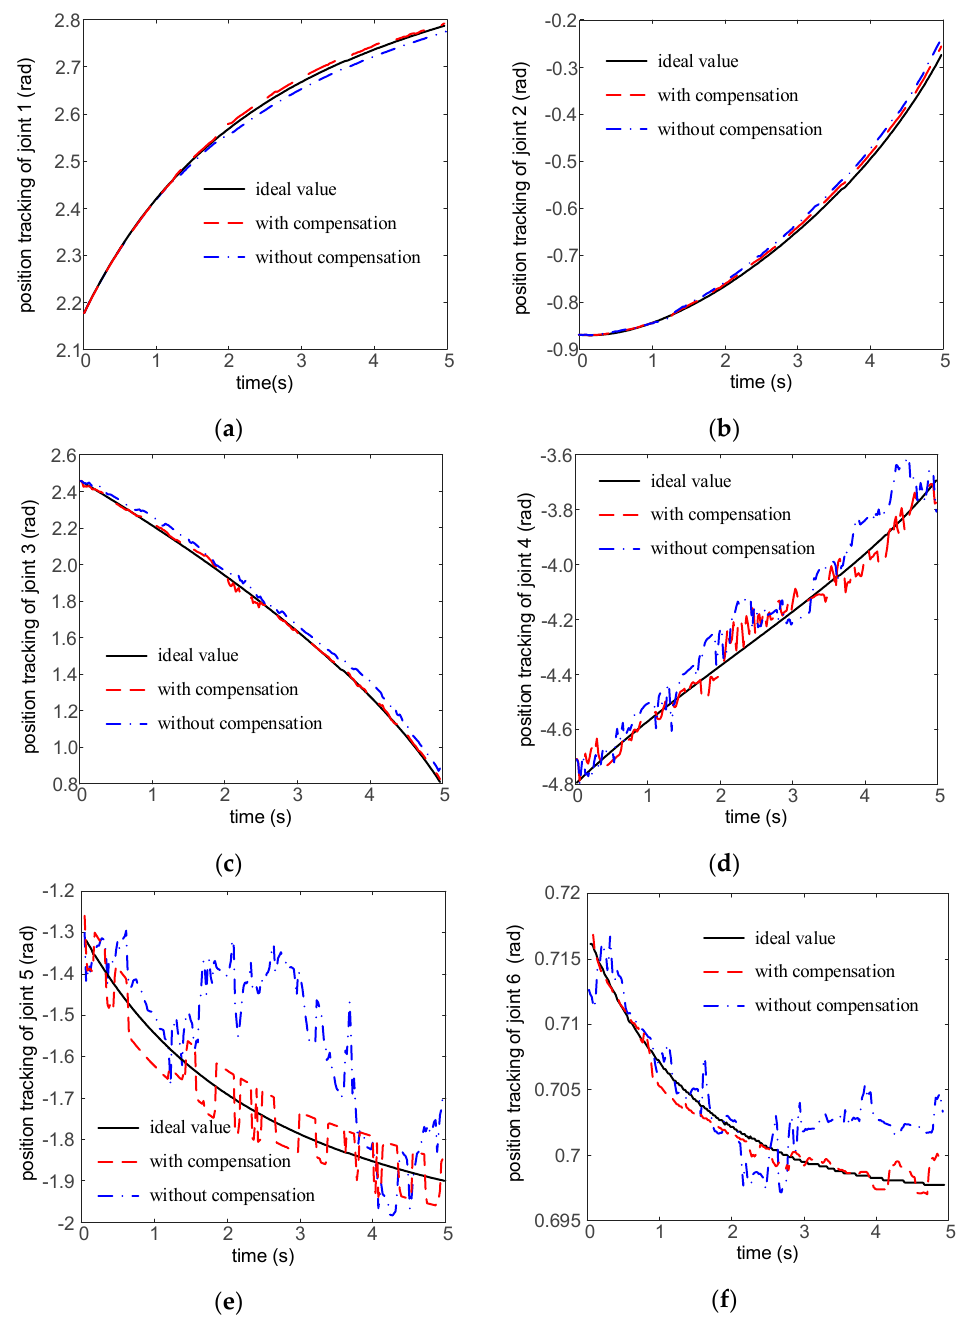
Figure 13. Position tracking performance of joint 1 ( a ), joint 2 ( b ), joint 3 ( c ), joint 4 ( d ), joint 5 ( e ), joint 6 ( f ).